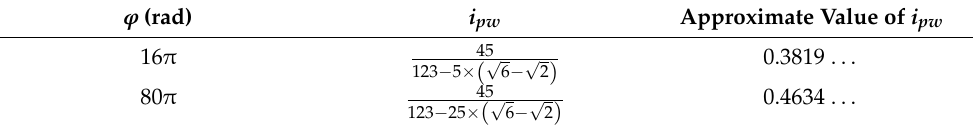
Figure 1. ( a ) Proposed single-side planetary lapping machine with irrational rotation speed ratio of lapping plate to workpiece; ( b-i ) the novel driving system design with a tapered roller and contact roller and ( b-ii ) its working mechanism; ( c-i ) the single-side eccentric abrasive lapping device and ( c-ii ) its working mechanism. Table 1. Variations of the i pw by adjusting the rotation angle of the screw rod, ϕ